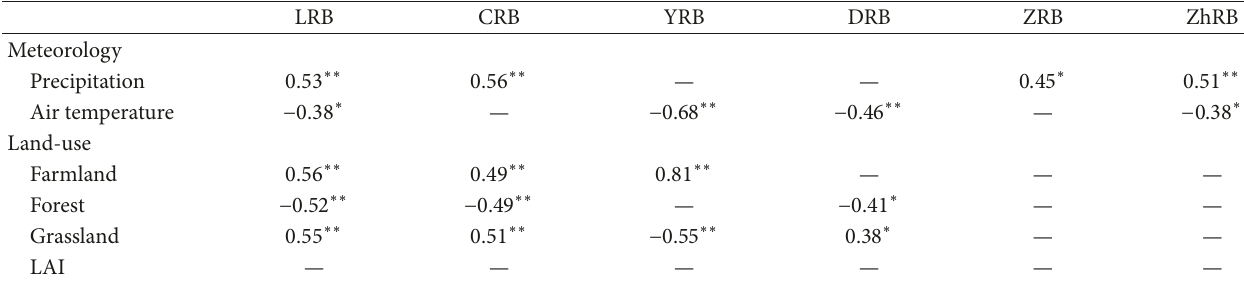
Table 2: Correlation coefficients for the relationship between runoff and environmental factors form 1980 to 2010.